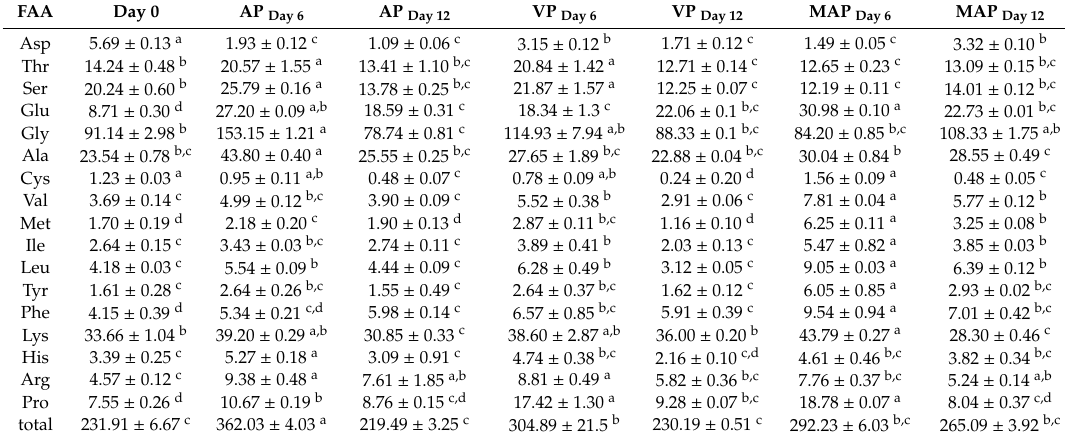
Table 1. Changes in free amino acid (FAA) content (mg / 100 g) of grouper muscle during refrigerated storage at 4 ◦